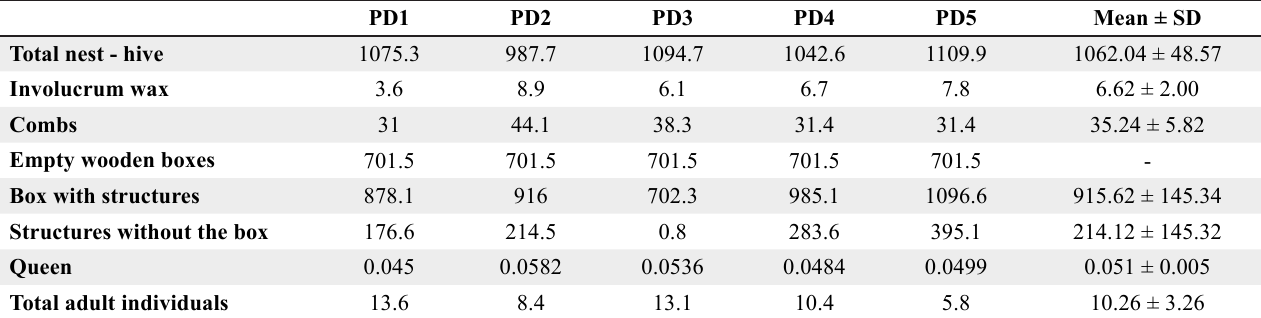
Table 2. Weight of the structures and individuals in the five different nests (in grams) and the mean ± SD to each item. The weight of the empty wooden boxes was the average between all colonies studied. T he “box with structures” refers to the weight of the wooden box with food pots, garbage dump and resin piles; and “structures without the box” refers to the weight without the mean of the empty wooden box, to calculate approximately the weight of the structures that remained inside the box.